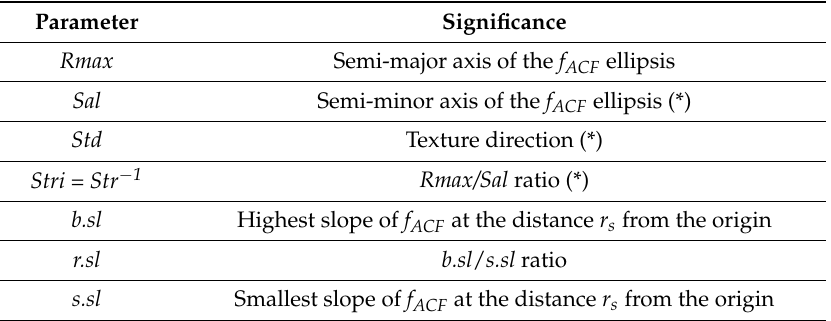
Table 2. Spatial parameters. (* ISO 25178).